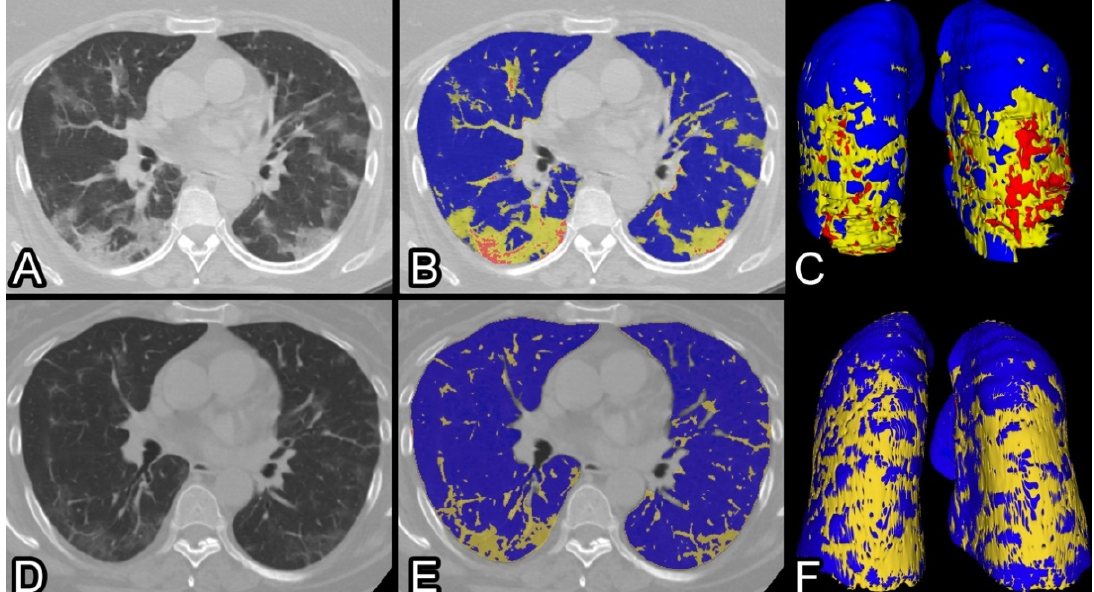
Figure 1. CT scans of a 57 years old lady affected by COVID-19 pneumonia, treated with non-invasive oxygenation during 11 days of hospitalization. At admission, she lamented dyspnea at rest, cough, thoracalgia and fever. ( A ) Non-contrast CT scan ad admission showing typical bilateral ground-glass consolidation ( B ) QCT of the same scan highlighting in yellow the poorly aerated and in red the non-aerated lung volumes ( C ) three-dimensional view of the whole lungs. After 44 days, a CT scan shows significant improvement ( D ) with subtle residual ground-glass opacities and linear scarring, better outlined at QCT ( E ) and using 3D reconstruction ( F ). At the follow-up clinical assessment, the patient lamented persisting laboured breathing and abrupt intermittent coughing. Residual %CL and %PAL were 6% and 5%, consequently %deltaCL and − %deltaPAL − 12% and − 10%. After binomial logistic regression analyses, the following variables were significant predictors of residual dyspnea: %deltaCL (OR 0.82, p = 0.03) and %deltaPAL (OR 0.81, p = 0.02); thoracalgia was correlated with %deltaPAL (OR = 1.11, p = 0.02) and length of hospitalization, either in the model with %delta CL (OR = 0.85, p = 0.04) and %deltaPAL (OR = 0.84, p = 0.03); persistent coughing was associated with increasing age (OR 1.11, p = 0.04). Results are detailed in Table